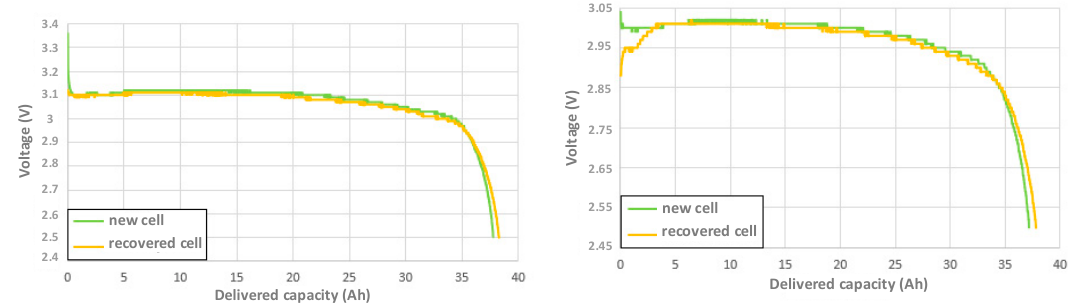
Figure 14. Voltage profile during discharge by 13 A ( left ) and 20 A ( right ) for regenerated (yellow) and referenced cell (green).